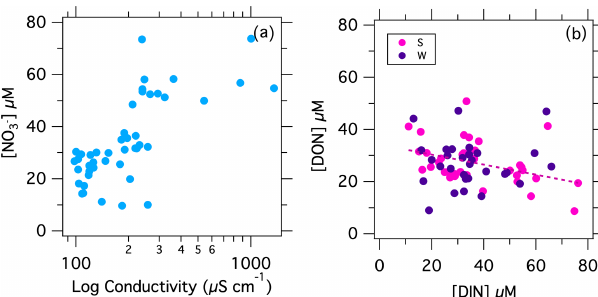
Figure 3. (a) [NO − ] in weekly samples at the Stillman Bridge vs. 3 conductivity (log scale). (b) Weekly [DON] at the Stillman and Westerly bridges vs. [DIN].